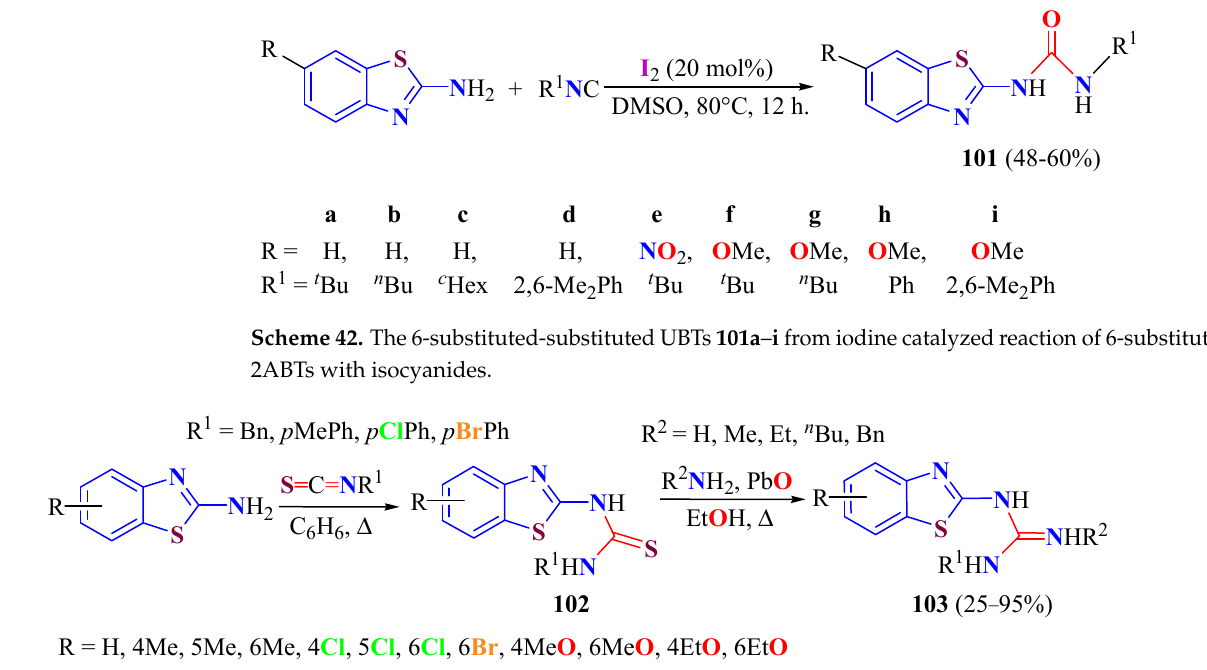
Figure 14. Substituted-sugar-TBTs 104 used as intermediates in the synthesis of substituted-sugar- GBTs.